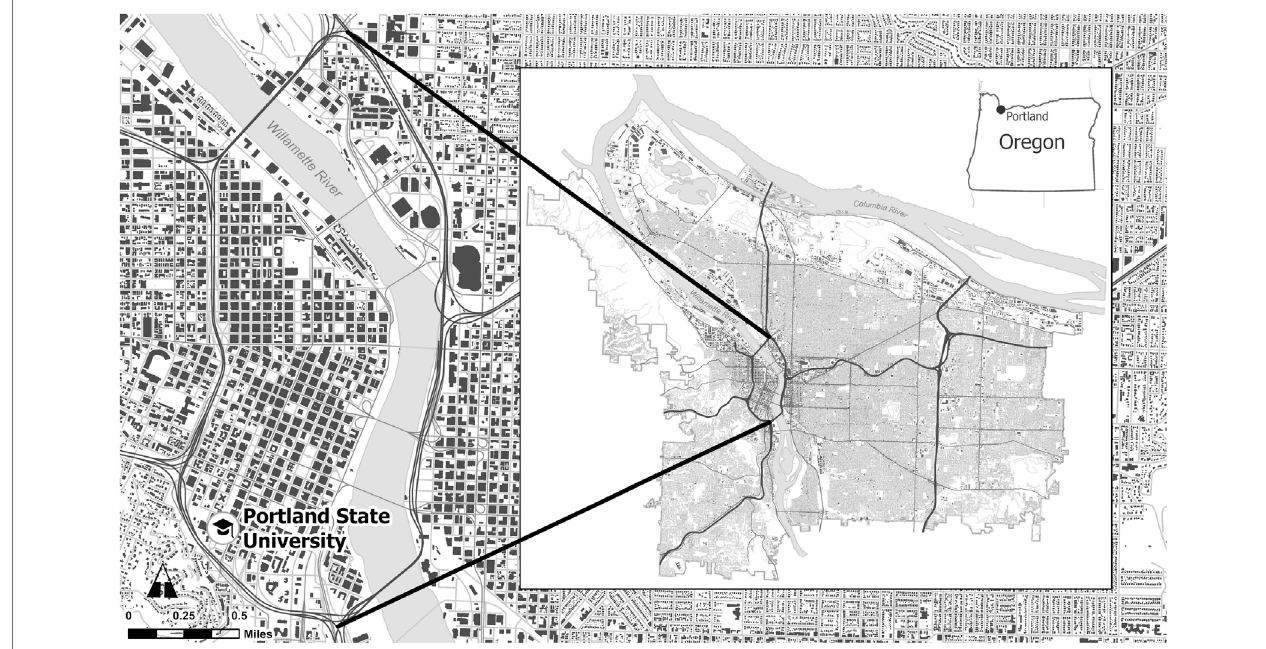
FIGURE 1 | Overview map of the location of our way fi nding case study, the campus of Portland State University in the downtown neighborhood of Portland,